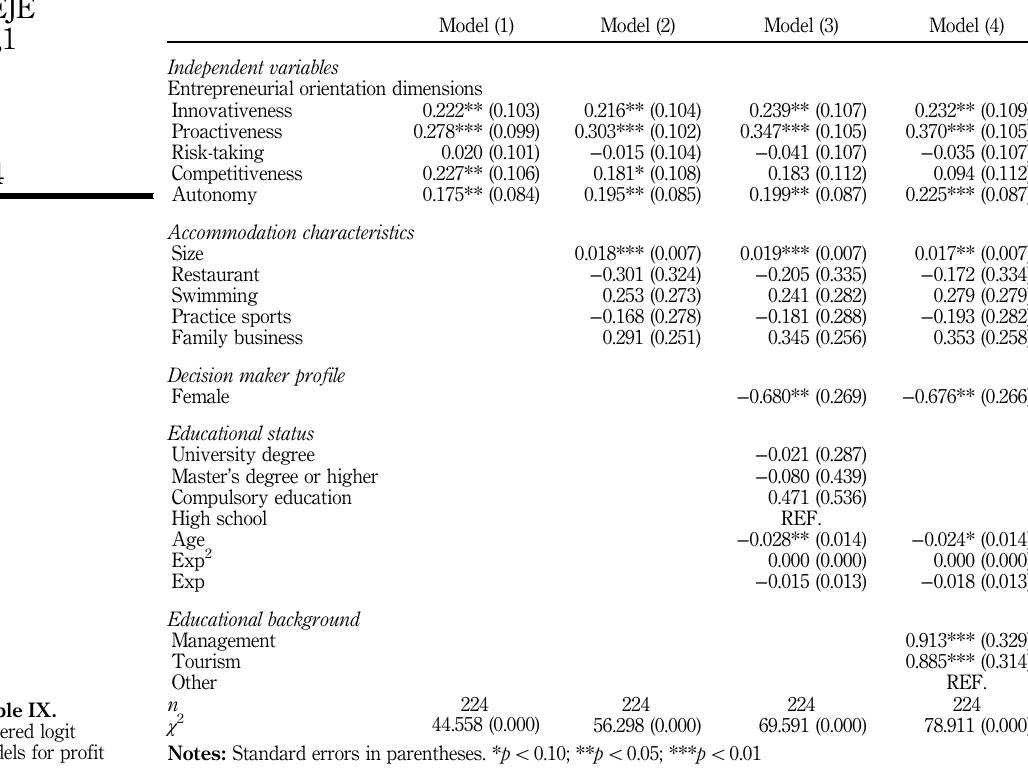
Table IX. Ordered logit models for